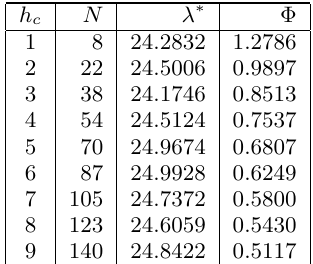
Table 2: Impact of h c on the fairness index